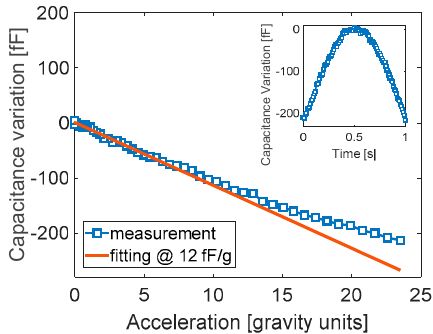
Figure 3. Measurement of the input-output curve of the proposed single-ended accelerometer up to large acceleration values. A good linearity is observed for external accelerations up to 7